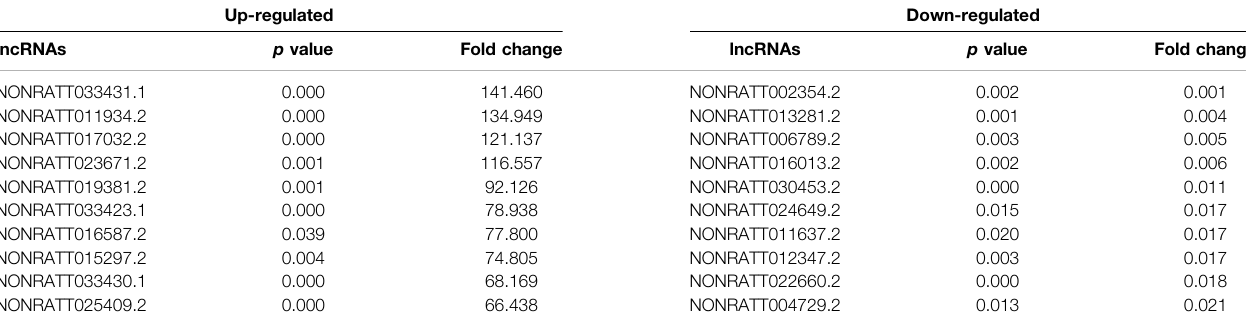
signi fi cantly up- and down-regulated lncRNAs. RT1-S2 (FC (cid:1) 116.382) and Ttc23 (FC (cid:1) 0.007) were the most